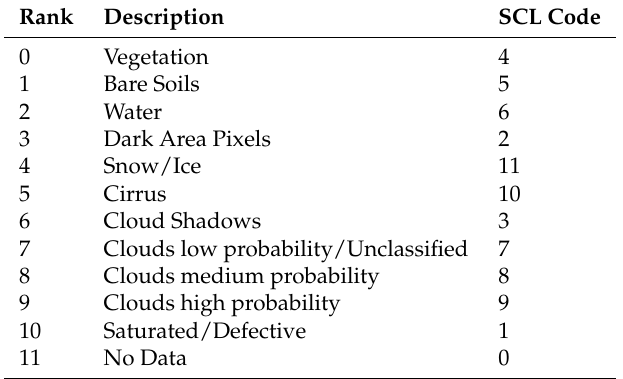
Table 1. Ranking of the scene classification used for the composite rule. Rank Description SCL